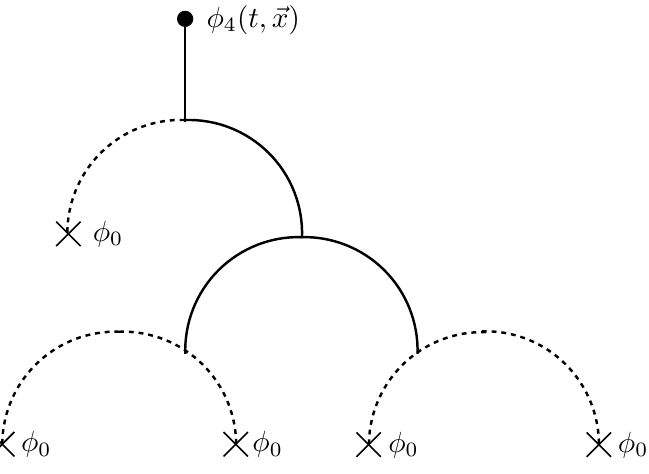
Figure 4 . Example of a classical perturbation theory Feynman diagram. In this case, it is the fourth-order perturbative correction, (cid:30) 4 ( t; ~x ), to the full (cid:12)eld solution, (cid:30) ( t; ~x ), in classical (cid:30) 3 theory. Solid lines are retarded propagators, G R , which get convolved with each other, and ultimately the free solutions (cid:30) 0 ( t i ; ~x i ). To make contact with our quantum (cid:12)eld theory diagrams, the free (cid:12)eld insertions are depicted as dashed lines leading to a \ ". If one were doing classical (cid:12)eld theory, (cid:2) one would need to use initial/boundary conditions or a speci(cid:12)c inhomogeneous source function to give a particular (cid:30) 0 for a corrected